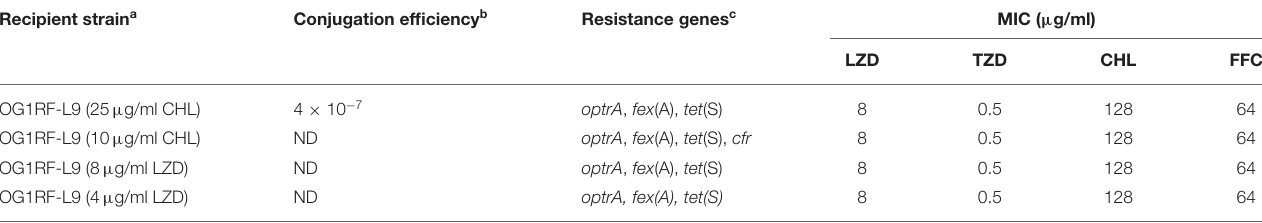
TABLE 1 | Conjugation efficiency of cfr and optrA from E. faecalis L9 to E. faecalis OG1RF transconjugants. Recipient strain